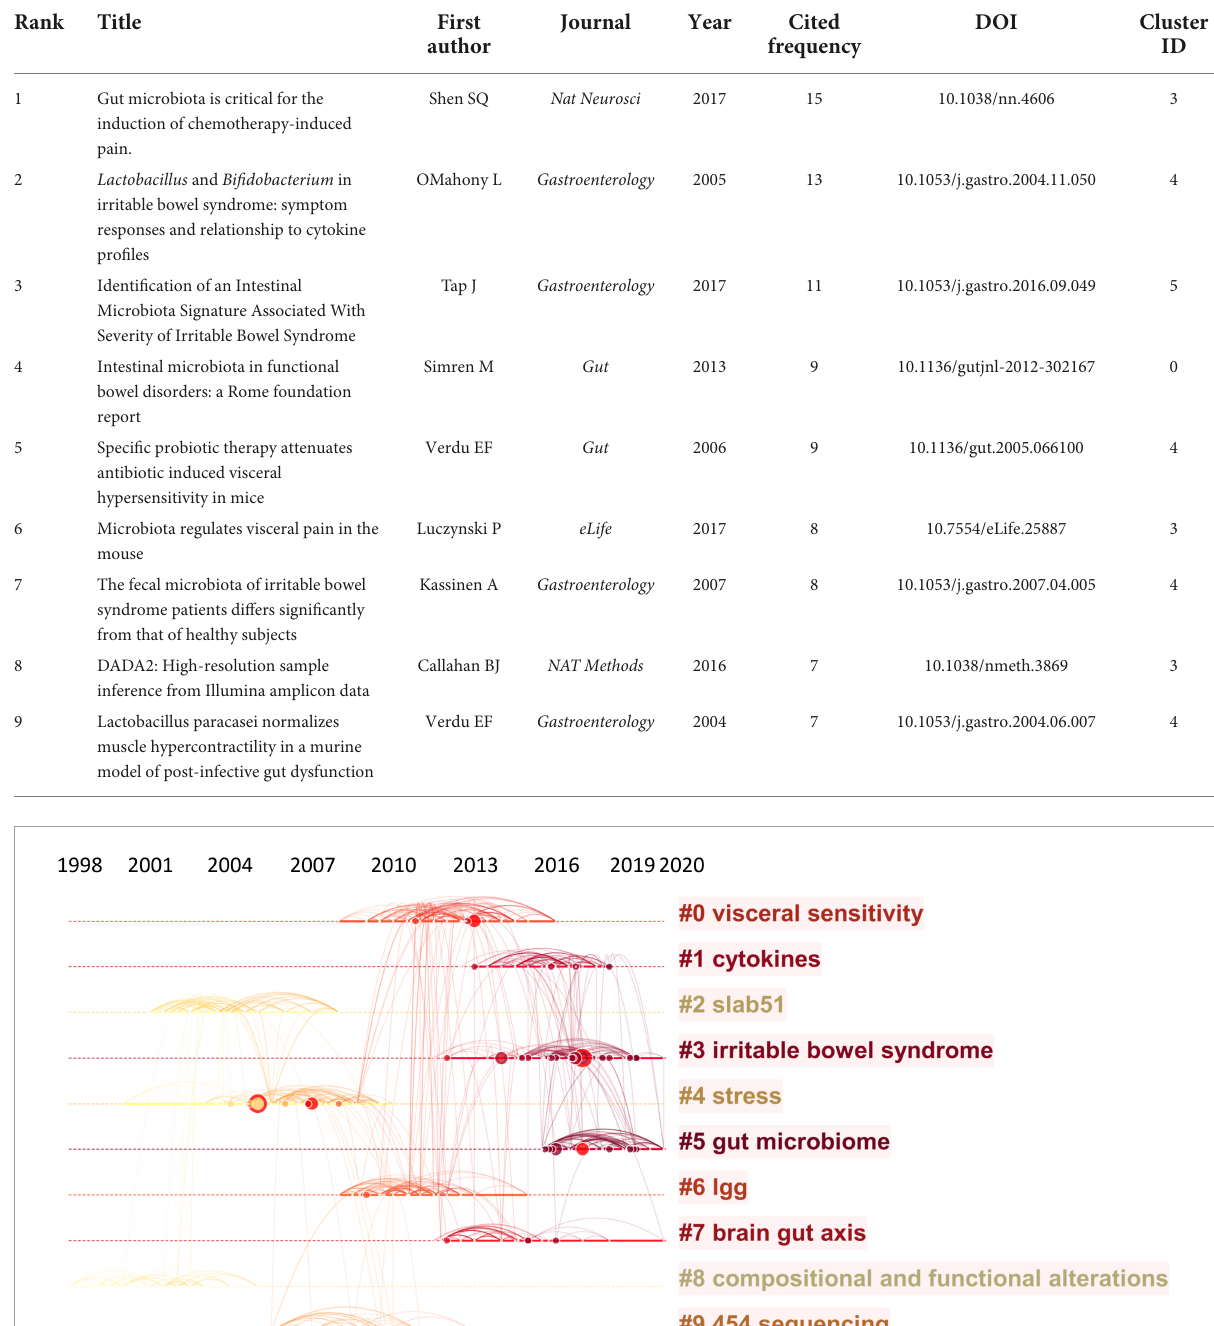
TABLE 3 The top 9 co-cited references related to the gut microbiota research in the pain field between 2002 and 2021.